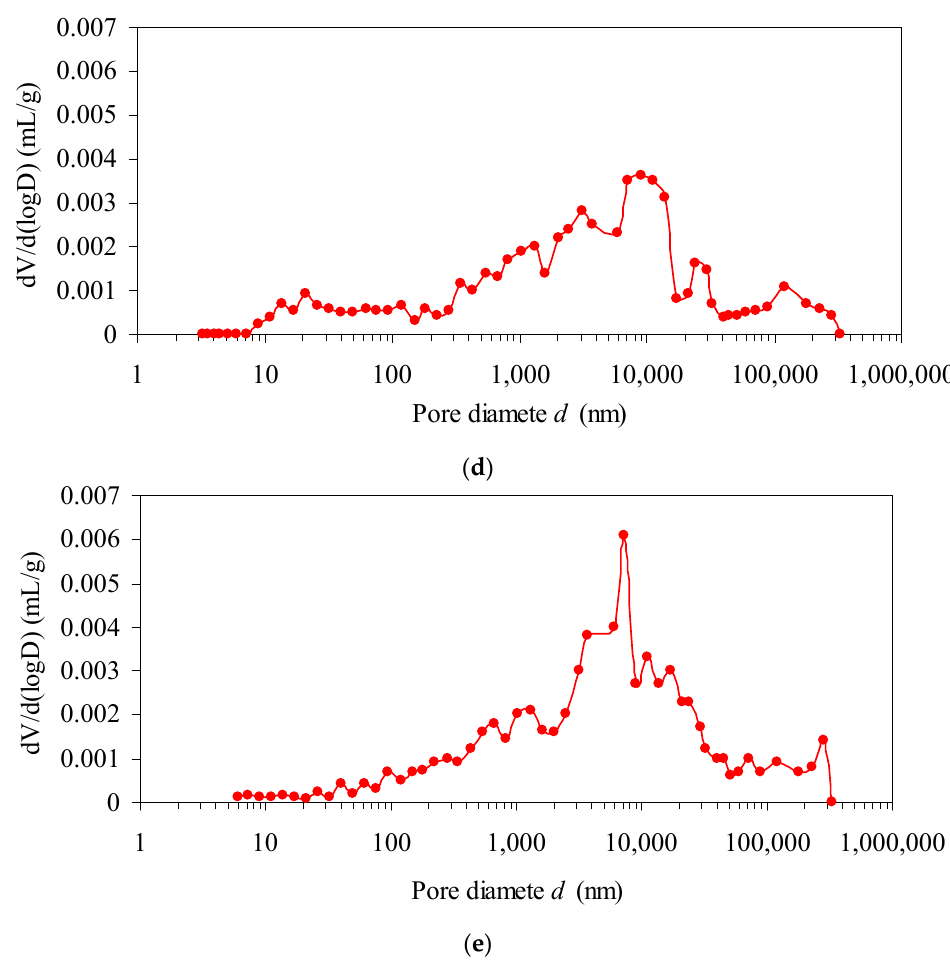
Figure 7. Pore size distribution. ( a ) 0 cycle; ( b ) 10 cycles; ( c ) 30 cycles; ( d ) 70 cycles; and ( e ) 100 cycles. 3.1.4. Porosity of Red Sandstone Porosity of red sandstone is presented in Table 2, and the change curve of porosity is shown in Figure 8.